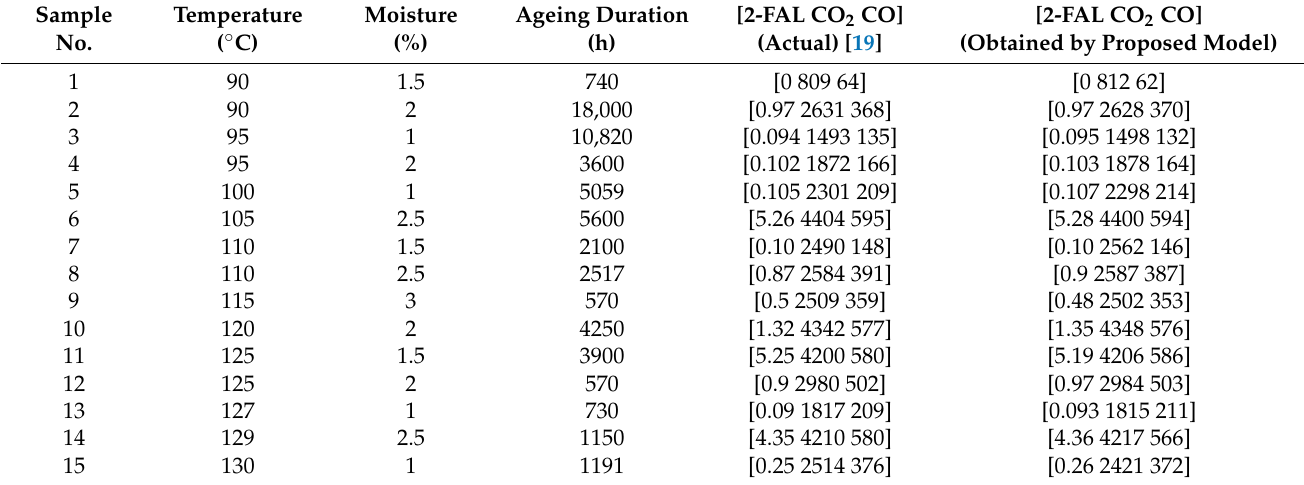
Table 2. Failure indices obtained from the proposed ANN model.